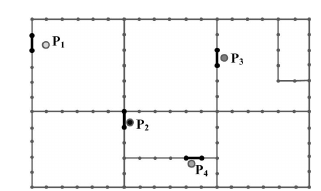
Figure 3. An illustrative example of the dilation operator based on the raster structure of planar space.